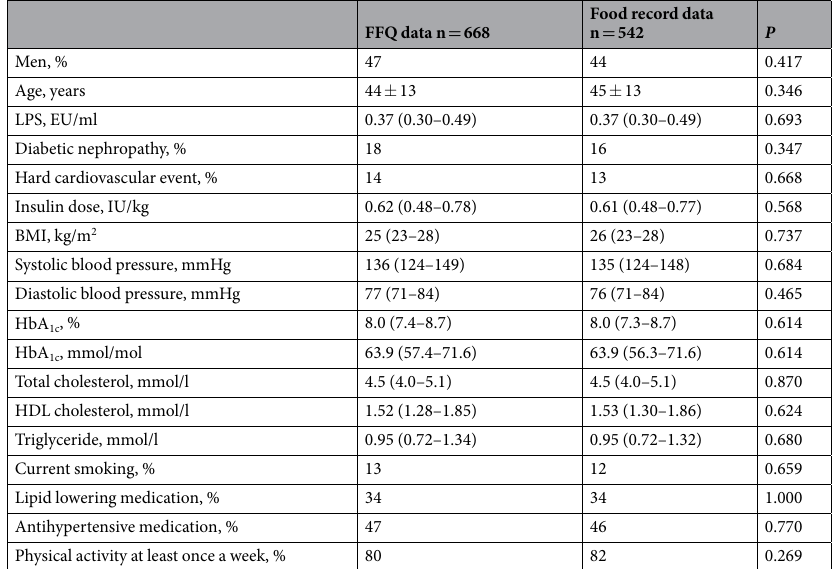
Table 1. Basic characteristics of the study population. In all 668 participants completed the food frequency questionnaire (FFQ). Of these, 542 additionally returned the food record. Data are presented as frequency (%), mean ± standard deviation, or median (interquartile range). LPS, lipopolysaccharide; Hard cardiovascular event, any major cardiovascular event (acute myocardial infarction, coronary bypass, stroke, amputation, peripheral vascular